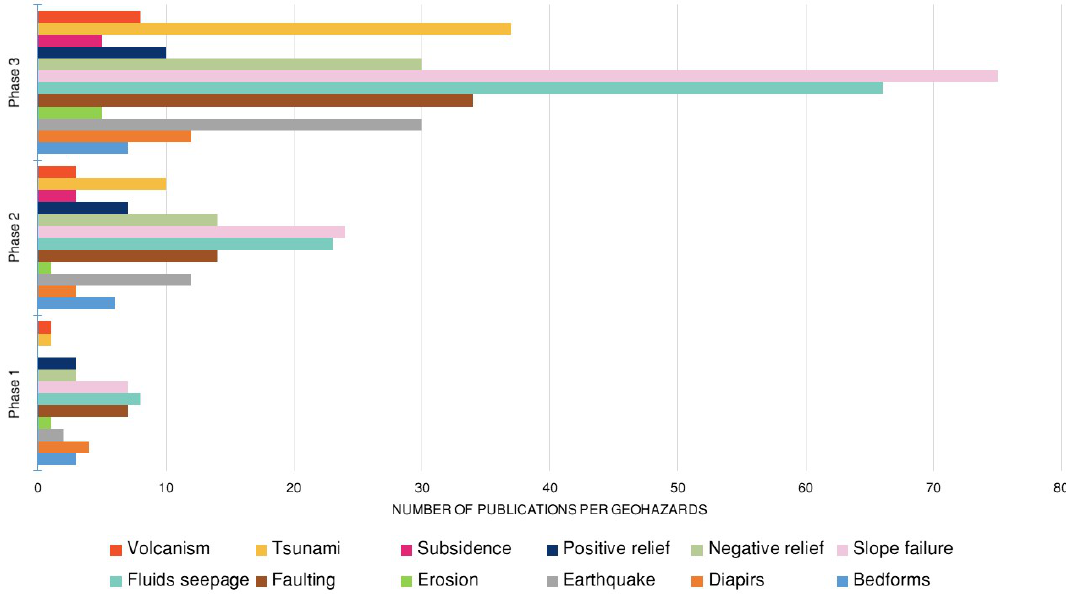
Figure 18. Number of publications per marine geohazard category during the distinct phases over the 35-year period analyzed.